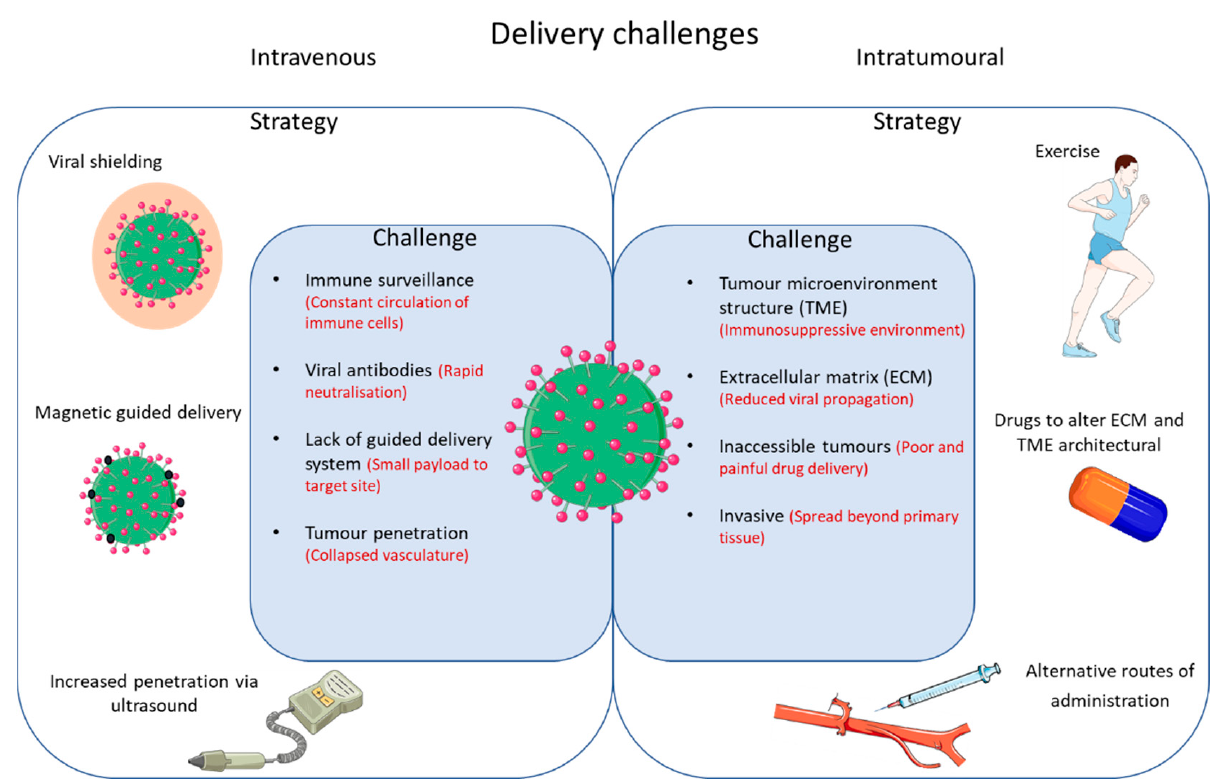
Figure 2. Outlined are some of the challenges and strategies in overcoming restricted delivery of OVs.